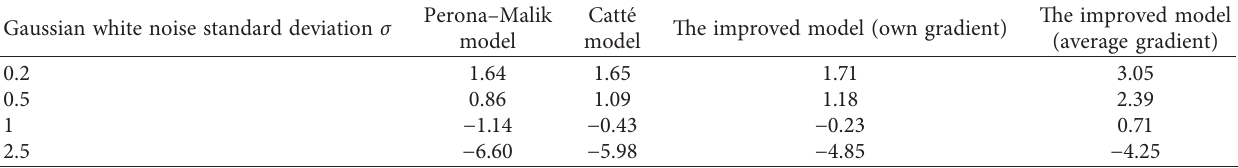
Figure 4: Comparison between original gradient and its average gradient. (a) Denoised signal with new operator. (b) Denoised signal with adaptive operator. Table 1: SNR of several denoising